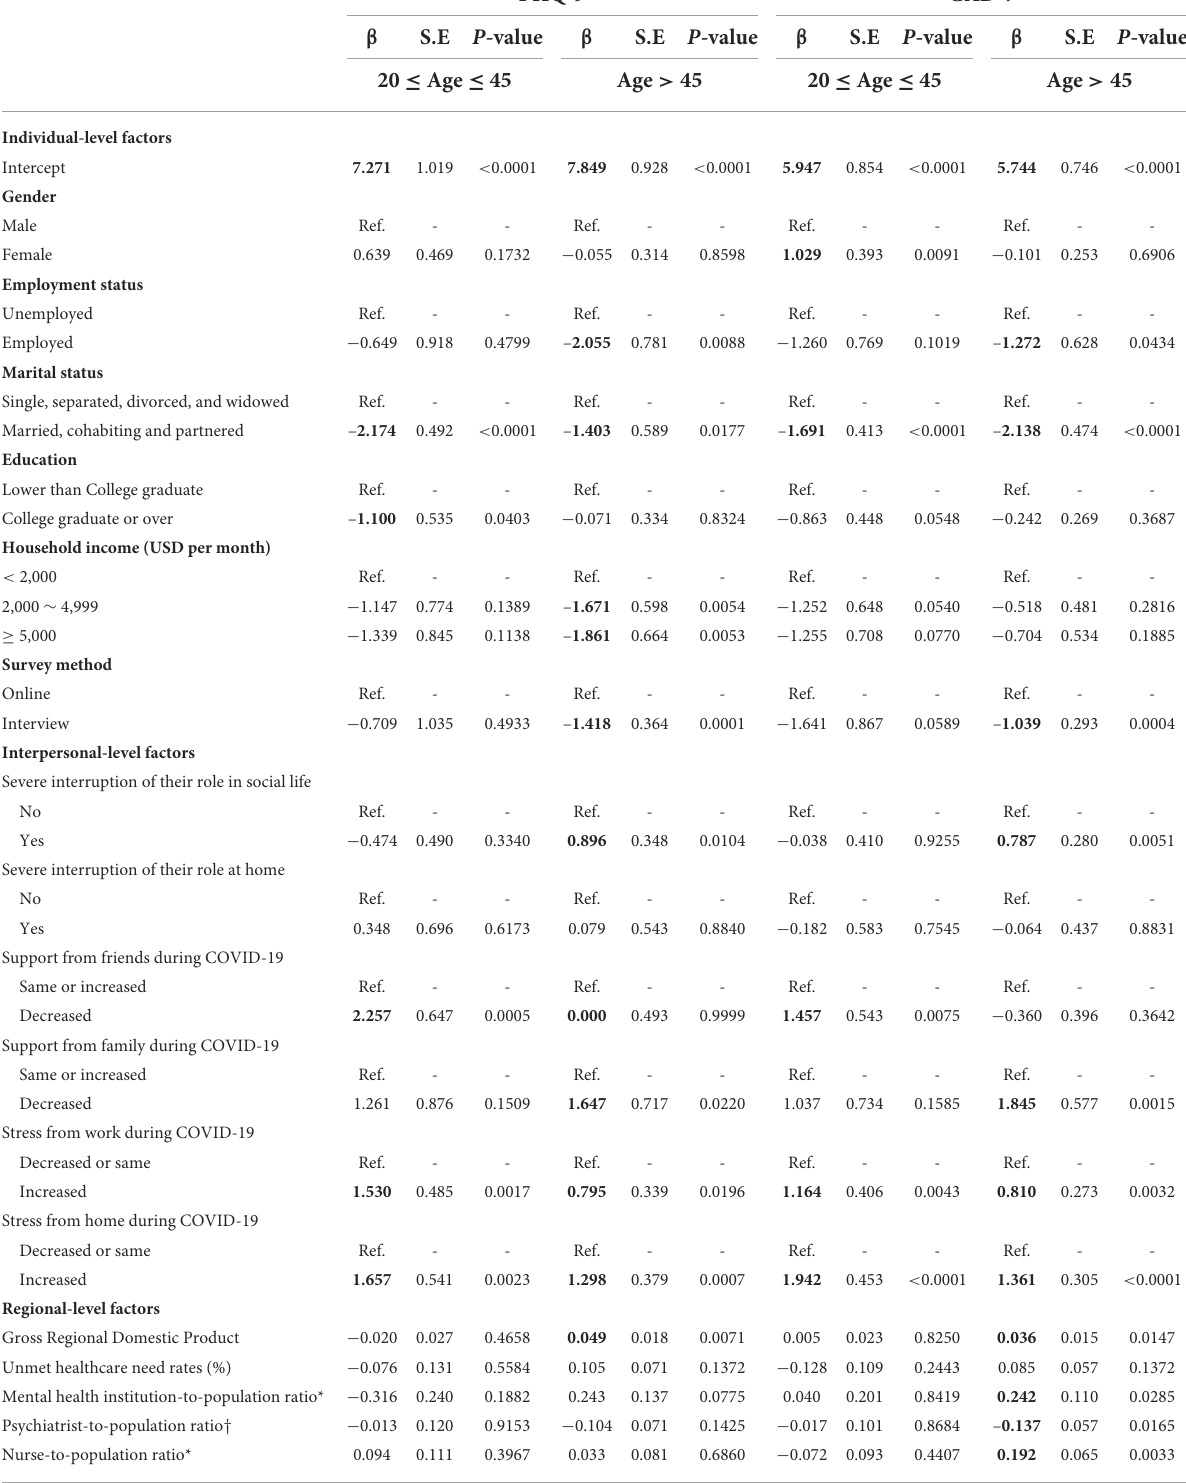
TABLE 3 Subgroup analysis of multiple linear regression for the effect of individual and community factors on mental health status by lifespan age